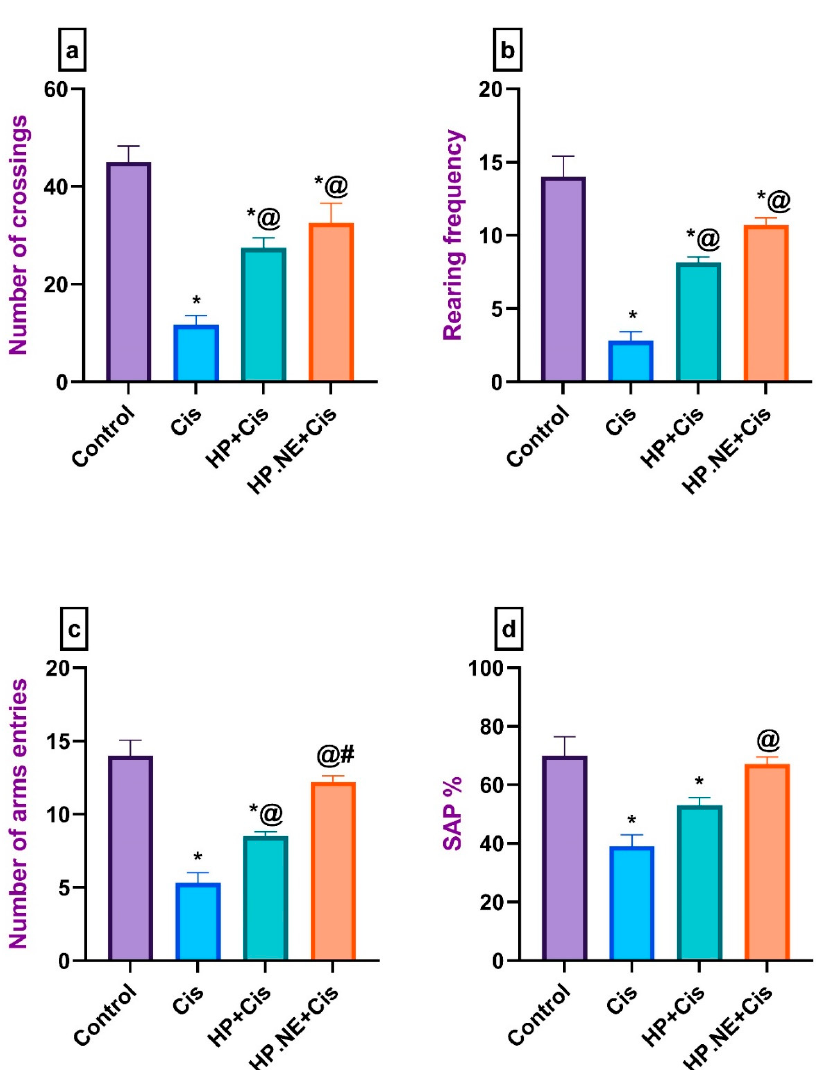
Figure 2. Effect of HP L. and HP.NE administration on the motor activity and spatial working memory of Cis-intoxicated rats. ( a ) Open field test: number of crossing squares, ( b ) open field test: rearing activity, ( c ) Y-maze test: number of arm entries, and ( d ) Y-maze test: spontaneous alternation percentage (SAP). Data are expressed as mean ± standard error (SE)using one-way analysis of variance (one-way ANOVA) followed by Tukey’s post hoc test for seven rats in each group. * means significant from the Control group; @, significant from the Cis group; #, significant from the HP +Cis group.